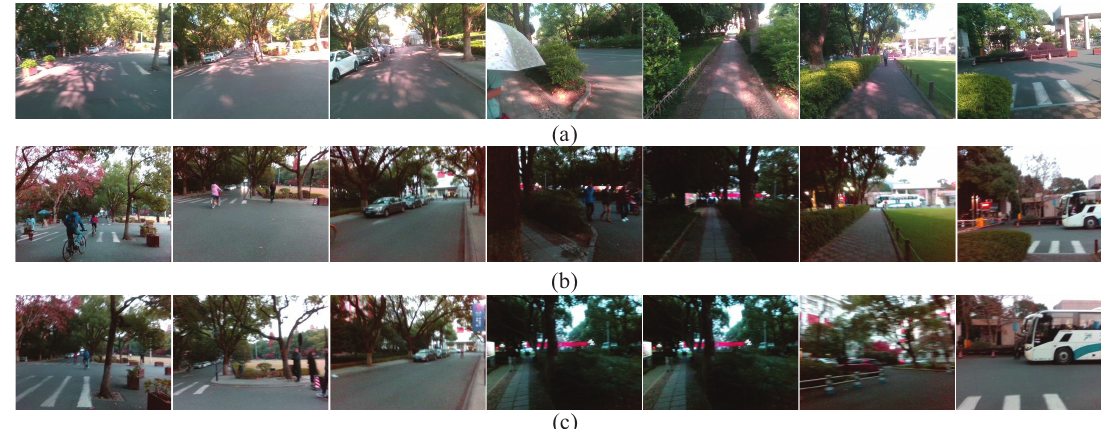
Figure 24. The comparisons of localization results between Visual Localizer and GNSS-based approach: ( a ) query images; ( b ) visual localization results; and ( c ) GNSS-based localization results. The localization results denote the matching images along the orange route as shown in Figure